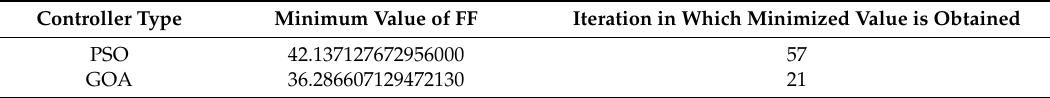
Table 1. Convergence values of PSOand GOA.